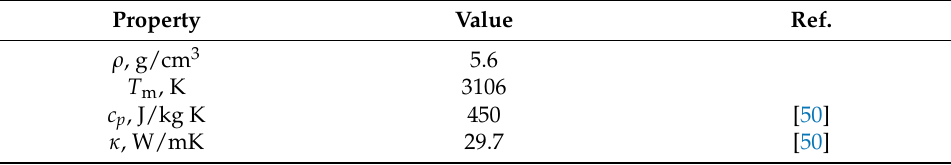
Table A7. Liquid -Ge—thermophysical properties.